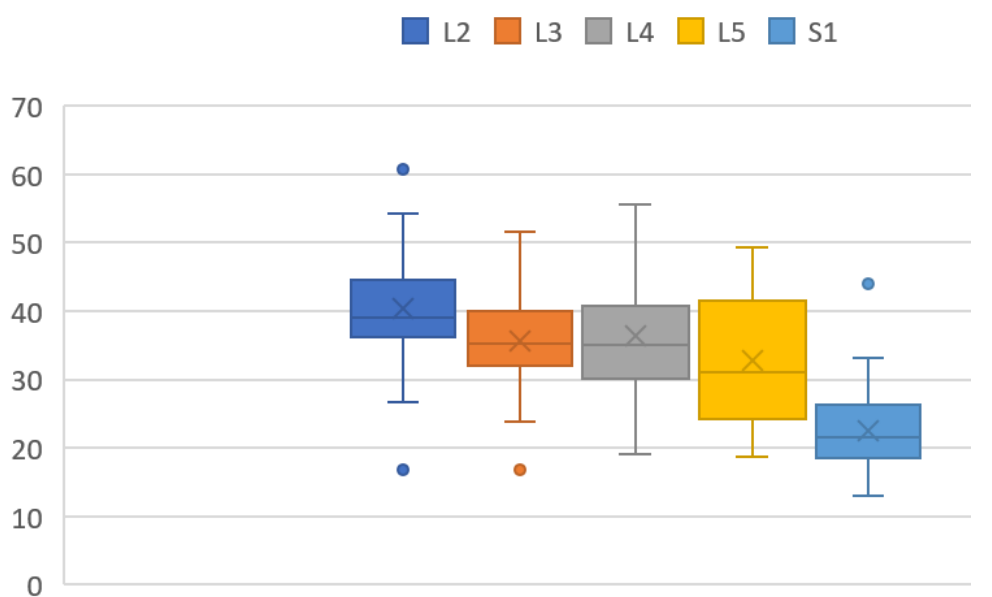
Figure 5. 3-D nerve root angulation (3DNRA). The dots indicate outliers.